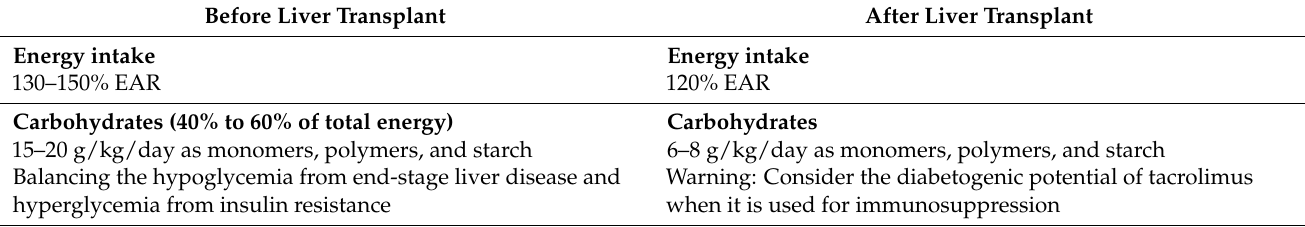
Figure 5. Nutritional needs of children with liver disease. BCAA, branched-chain amino acids; CHO, carbohydrates; LCP, long chain polyunsaturated fatty acids; MCT, medium-chain triglycerides; PUFA, polyunsaturated fatty acids. Table 3. Nutritional needs of children with chronic cholestatic liver diseases before and after liver